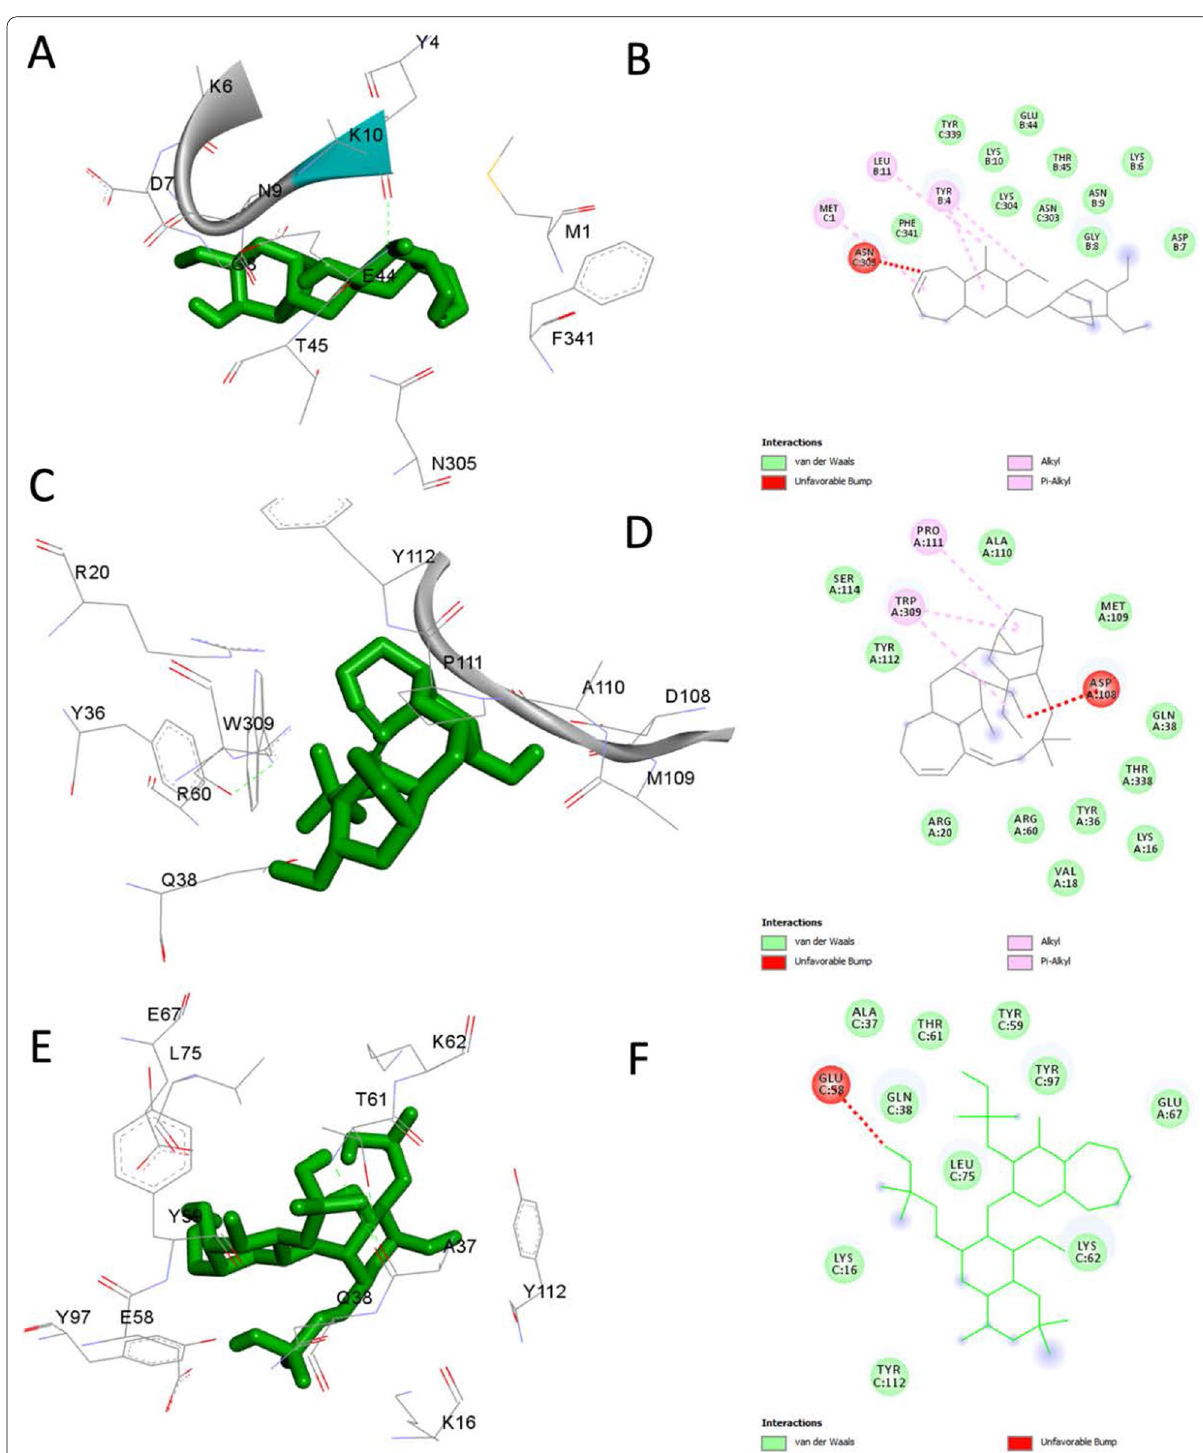
Fig. 3 Molecular interactions of S. typhi OmpF with carrageenan lambda 3D interaction ( a ) and 2D interaction ( b ); carrageenan/MIV-150 3D interaction ( c ) and 2D interaction ( d ); 3,6-anhydro-D-galactose-2-sulfate 3D interaction (e) and 2D interaction ( f